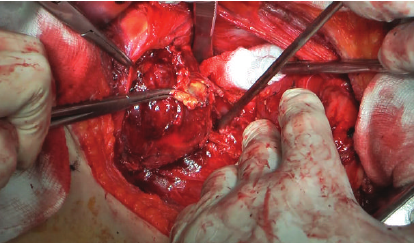
Figure 4: Quick dissection and ligation of right adrenal vein.